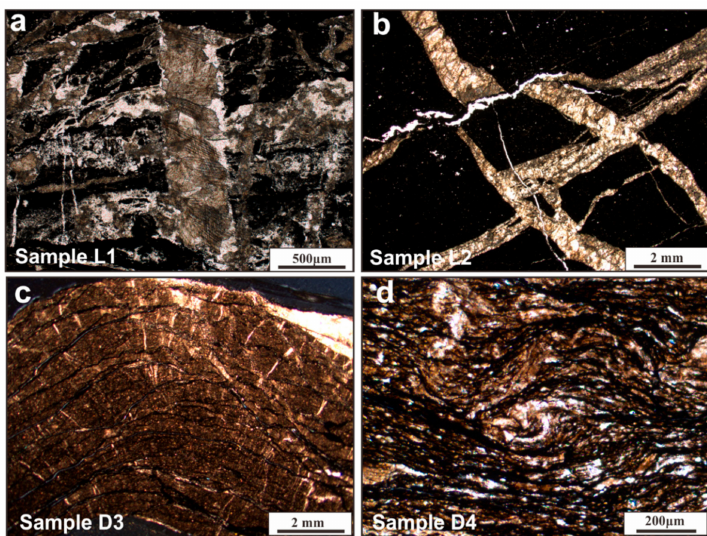
Figure 2. Optical photomicrograph of sample L1 ( a ) and L2 ( b ). Brittle deformation and “X” joints can be found, showing complex cross-cutting relationships. Optical photomicrograph of sample D3 ( c ) and D4 ( d ). Deformation continued after veins formation, resulting in the development of fault-fold microstructures, rotated porphyroclast, and further